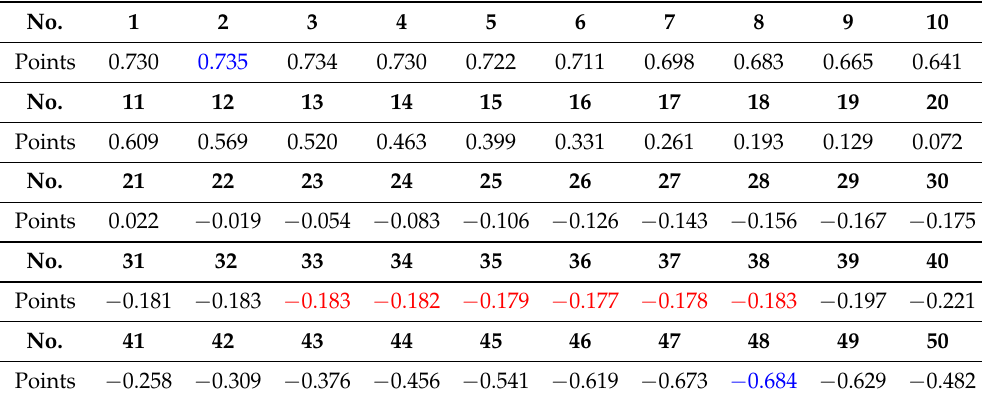
Table 3. Partial ECG signal sequence of the number 100 subject (Red marks denote noise and blue marks denote feature